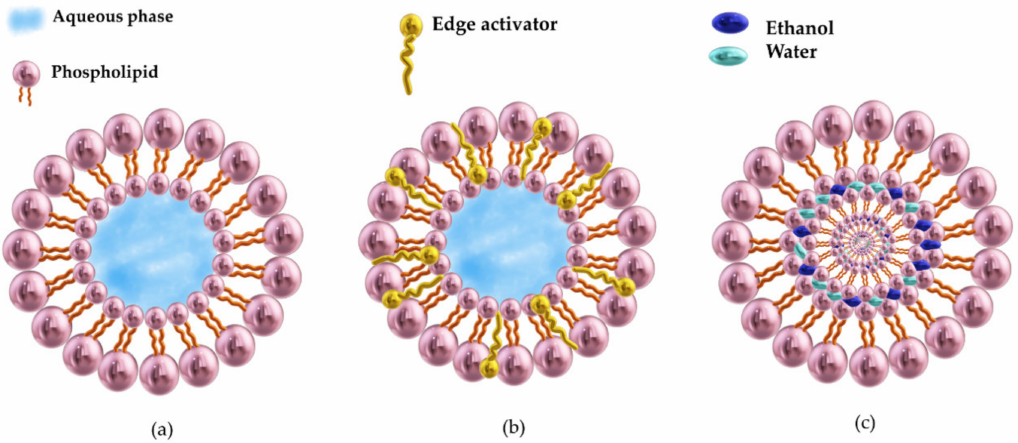
Figure 5. Membrane structure of ( a ) conventional liposome, ( b ) transfersome (with edge activators), ( c ) ethosome (with ethanol and water between the